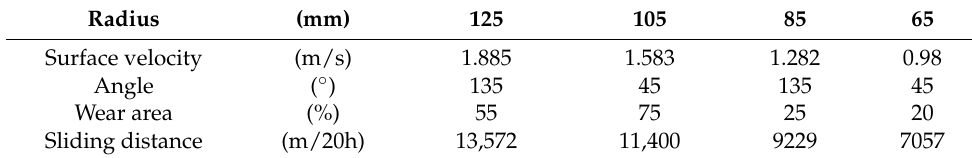
Table 3. Slurry pot test